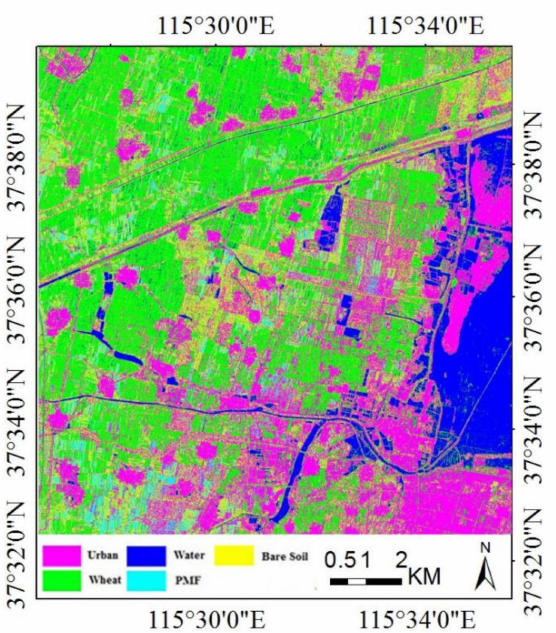
Figure 3. Classification map based on dual-polarimetric TerraSAR-X data.